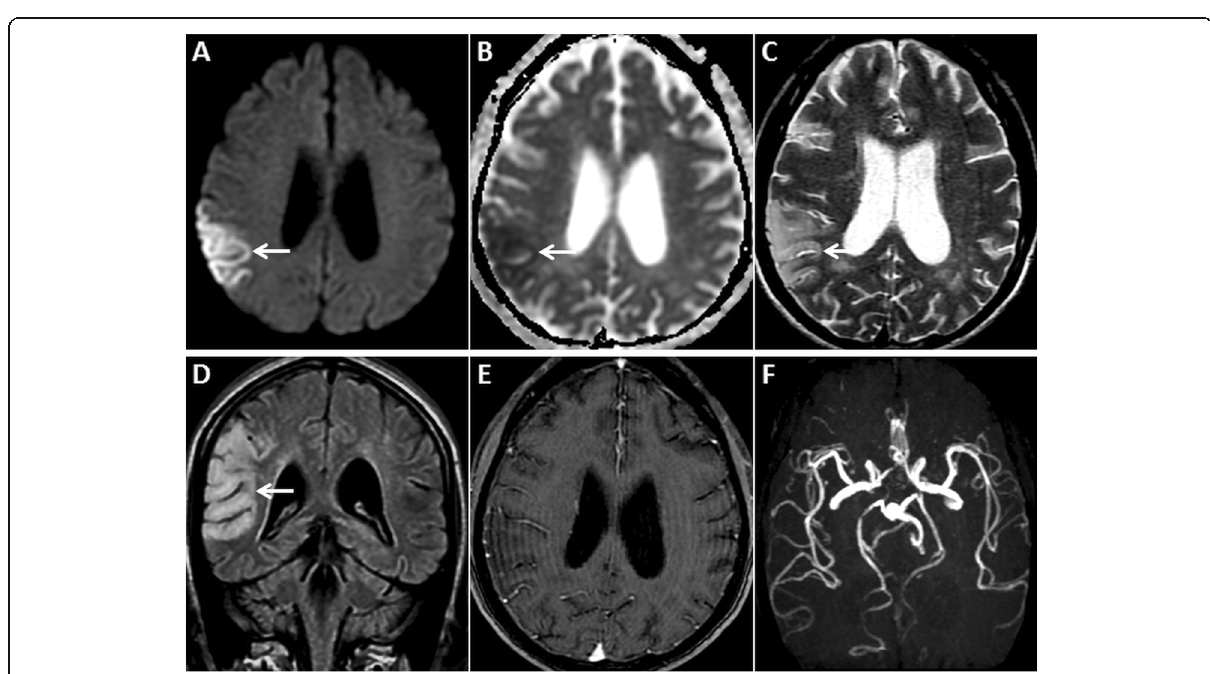
Fig. 11 Pre- and post-contrast MRI of the brain in a 45-year-old male patient with proven MELAS on muscle biopsy. GRD is observed in the right parietal cortex (arrows) on axial DWI ( a ) and ADC image ( b ). Associated gyral swelling and hyperintense signal (arrows) is seen on axial T2W ( c ) and coronal FLAIR image ( d ). No enhancement is seen in this region on post-contrast axial T1W image ( e ). Reconstructed maximum intensity projection MRA image of Circle of Willis ( f ) confirms no large vessel occlusion